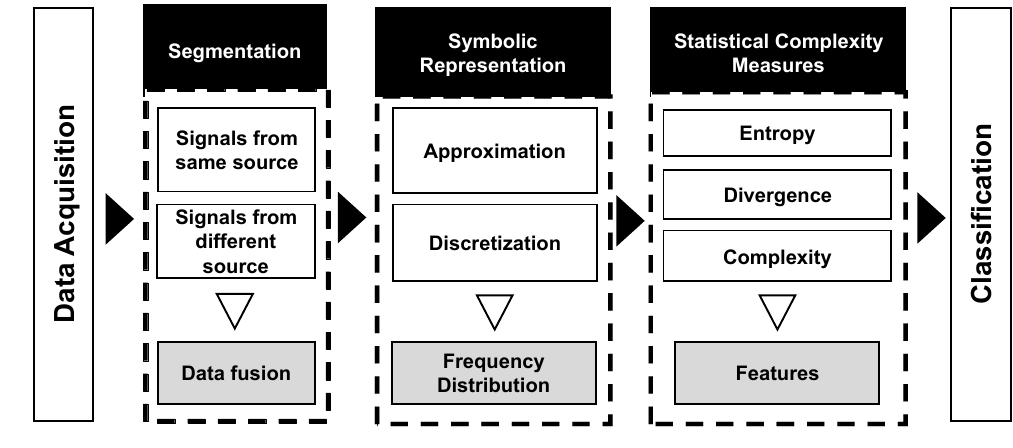
Figure 5. Overview of the HAR-SR